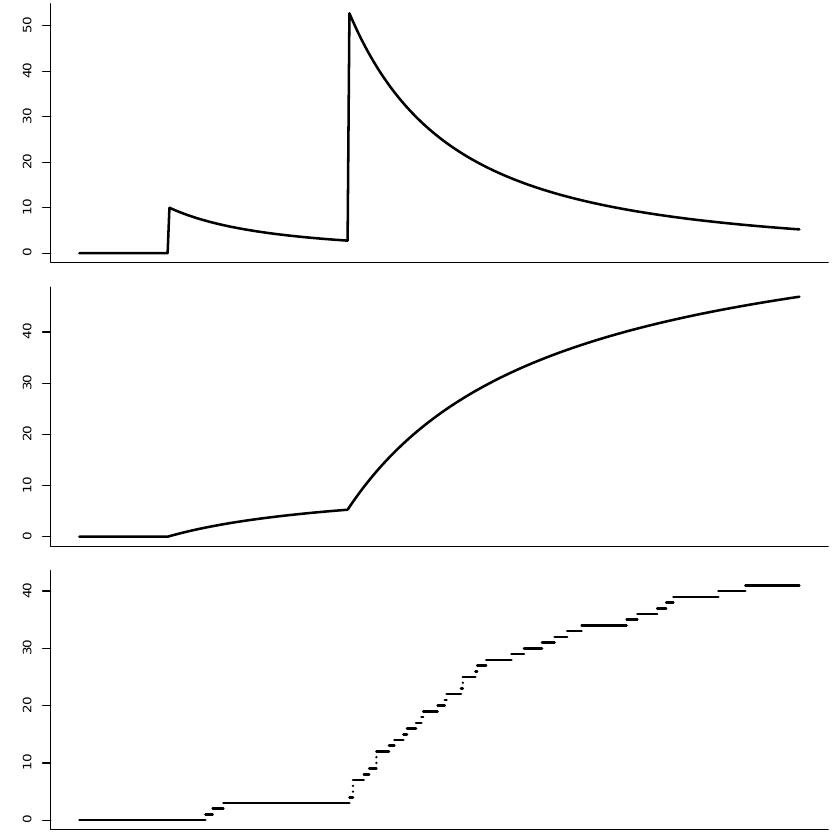
Figure 3. Simulation of a claims process driven by a shot-noise process with rational structure. The graph shows the intensity process (cid:96) ( Top ), the cumulated intensity process (cid:82) t L ( t ) = (cid:96) ( s ) ds ( Middle ) and the simulated claims process 0